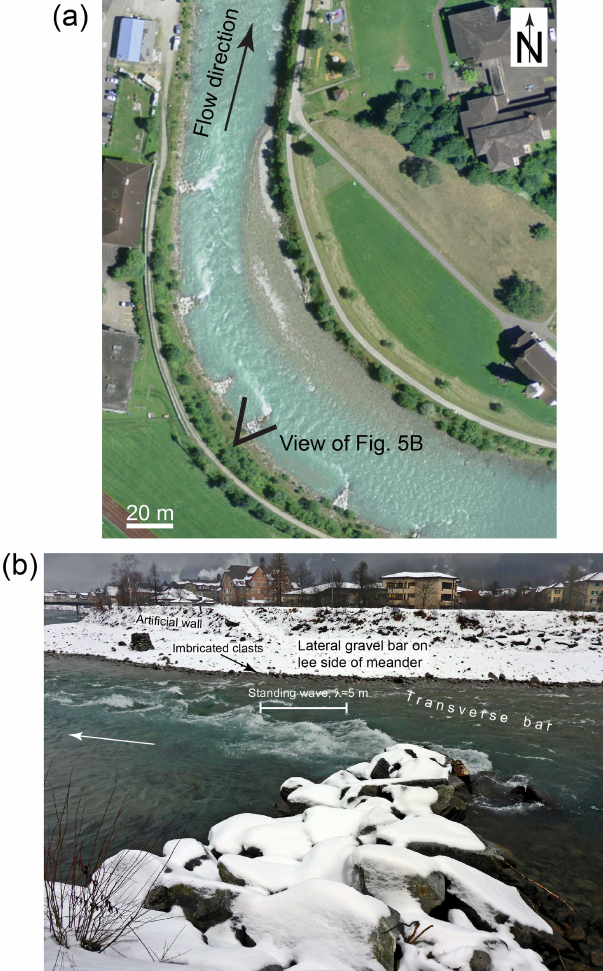
Figure 5. (a) Reuss river with evidence for standing waves along the thalweg. Orthophoto reproduced with the permission of swis- stopo (BA 18065). Please see Fig. 2 for location. (b) Transverse and lateral bars in the Reuss river with imbricated clasts on the lateral bar forming a riffle, and standing waves where the thalweg crosses the riffle. The wavelength of the standing wave is ca. 5m. Arrow indicates flow direction. Please see Figs. 2 and 5a for location of